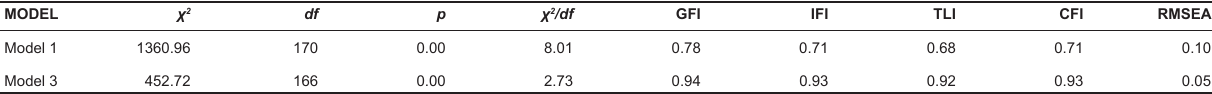
TABLE 2 Goodness-of-fit statistics for the comparison of the adapted MBI-GS